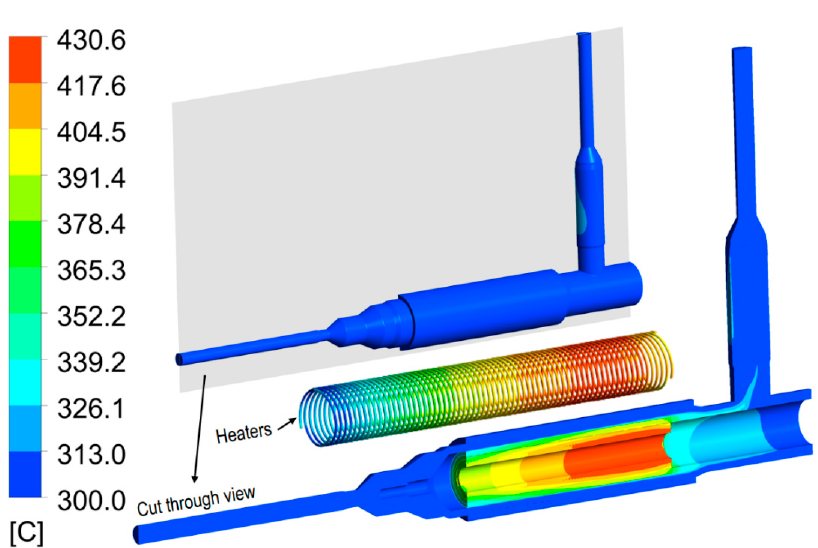
Figure 9. Temperature contour of the mockup.